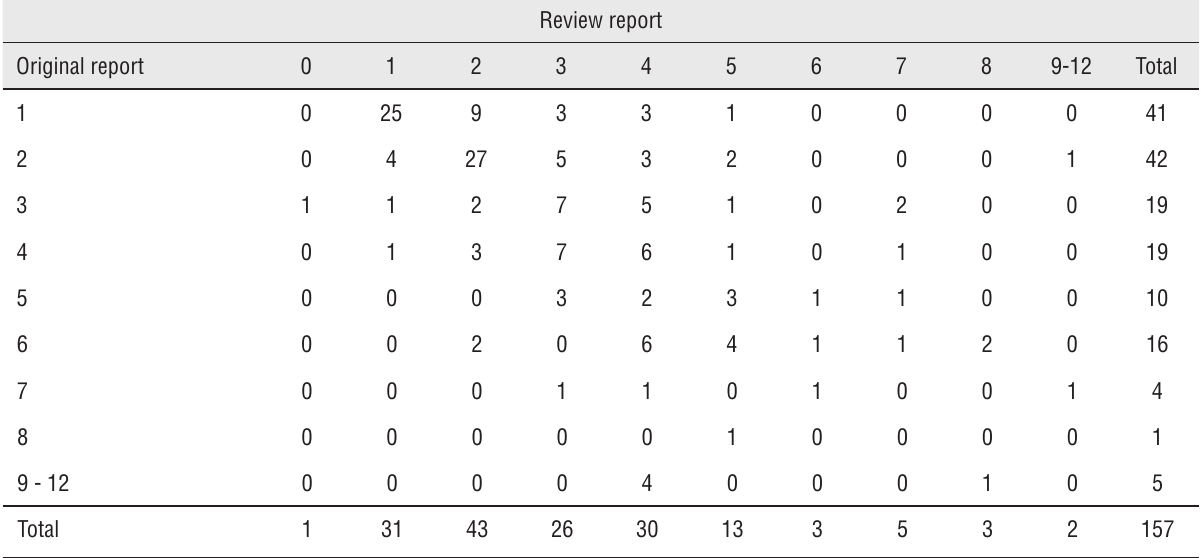
Table 2 - Number of cores positive for tumors. Comparison between the first and the review